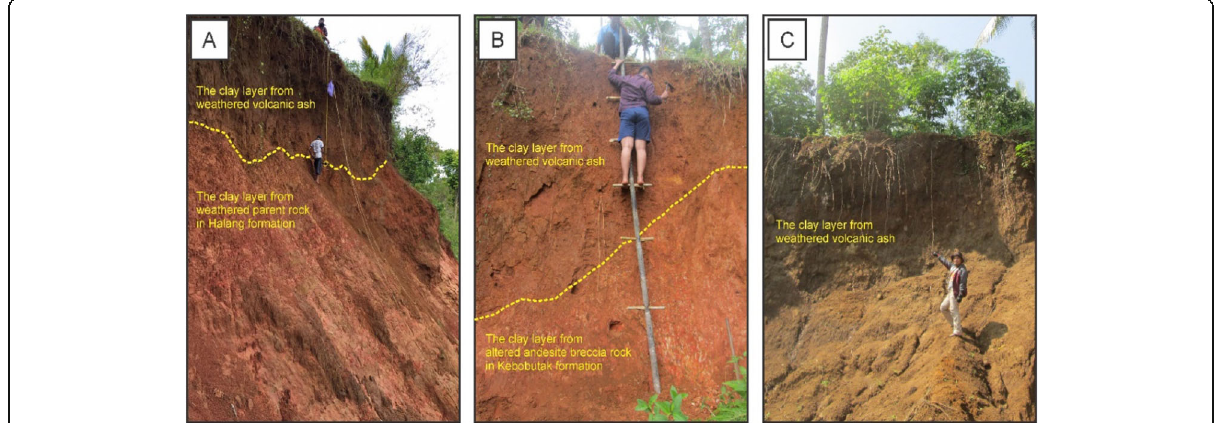
Fig. 5 Soil and weathered rock materials in the main scraps of: Tegalsari ( a ), Wonogiri ( b ) and Manglong ( c )